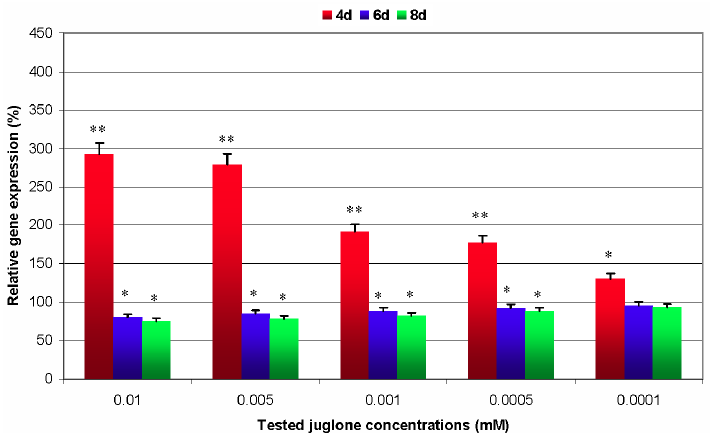
Figure 4. Juglone-induced changes in levels of relative expression of GstI gene in coleoptiles of maize seedlings. 100%—the reference level of gene expression in untreated maize seedlings; * p < 0.05, ** p < 0.01 (Student’s t -test)—significant differences in relative gene expression between the tested treatment group and the control group of seedlings.